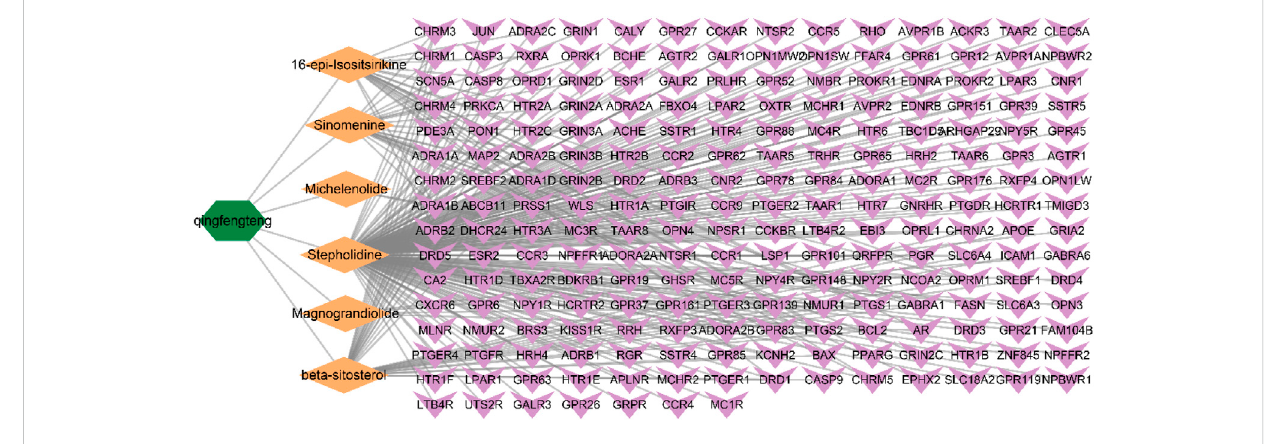
FIGURE 2 Network diagramof SA — Active ingredient — Target. Thegreen colorrepresentsthedrug SA, theorangediamond represents theactive ingredient of SA, and the purple arrow represents the target protein. The lines represent the relationship between drug, active ingredient, and target.